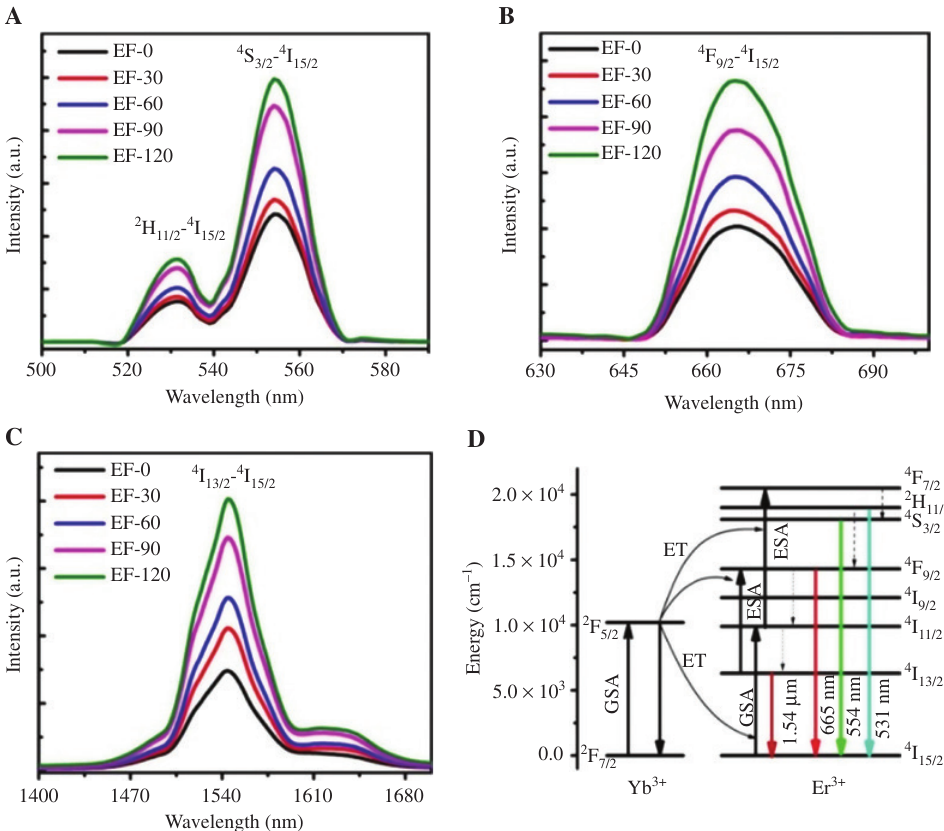
Figure 3: The electric-induced enhancements of visible and near-infrared emission, and schematic diagram of the energy levels. - 4 I and 4 S - 4 I transitions with increasing electric fields. (B) The upconversion (A) The upconversion emission spectra of Er 3 + : 2 H 11/2 15/2 3/2 15/2 emission spectra of Er 3 + : 4 F - 4 I transition with elevated electric fields. (C) The NIR emission of Yb 3 + /Er 3 + doped samples with different 9/2 15/2 electric fields. (D) Schematic diagram of the energy levels of Yb 3 + /Er 3 + in the